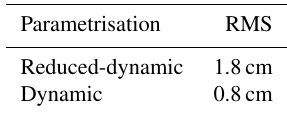
Table 2. K-band RMS over all days using epoch-wise covariances in the orbit reconstruction for April